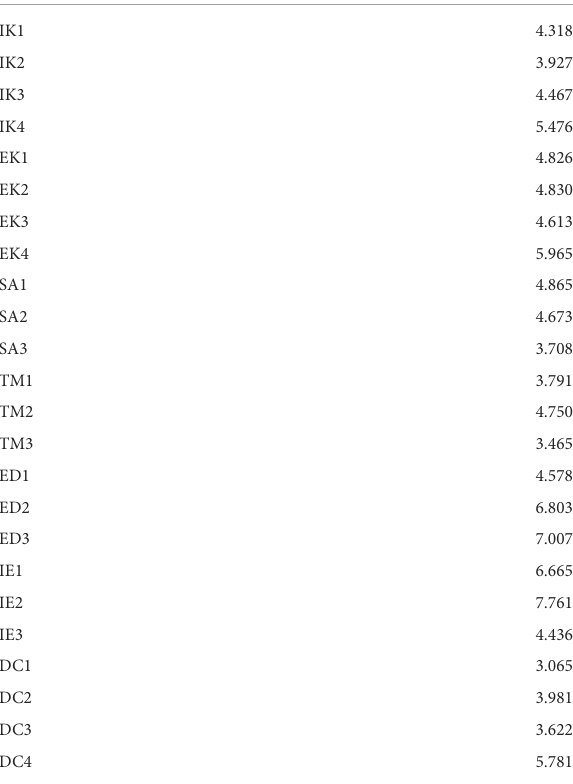
TABLE 6 Collinearity